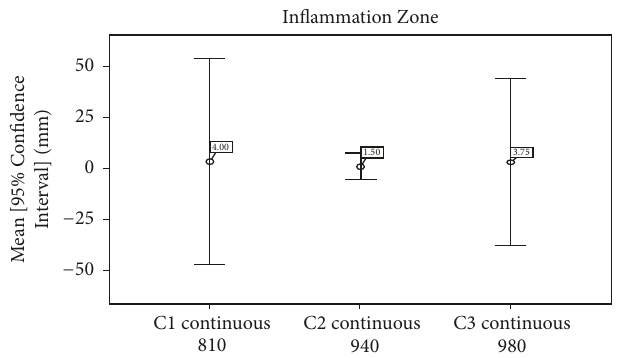
Figure 9: Lower inflammatory response in group C2 versus groups C1 and